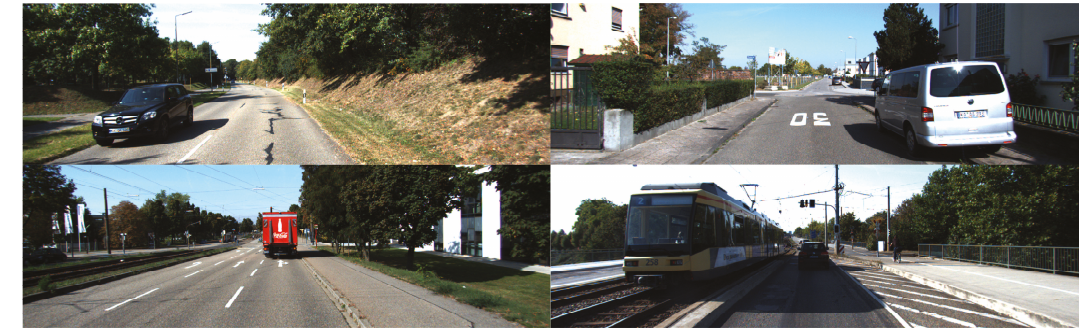
Figure 4. The example image of the KITTI